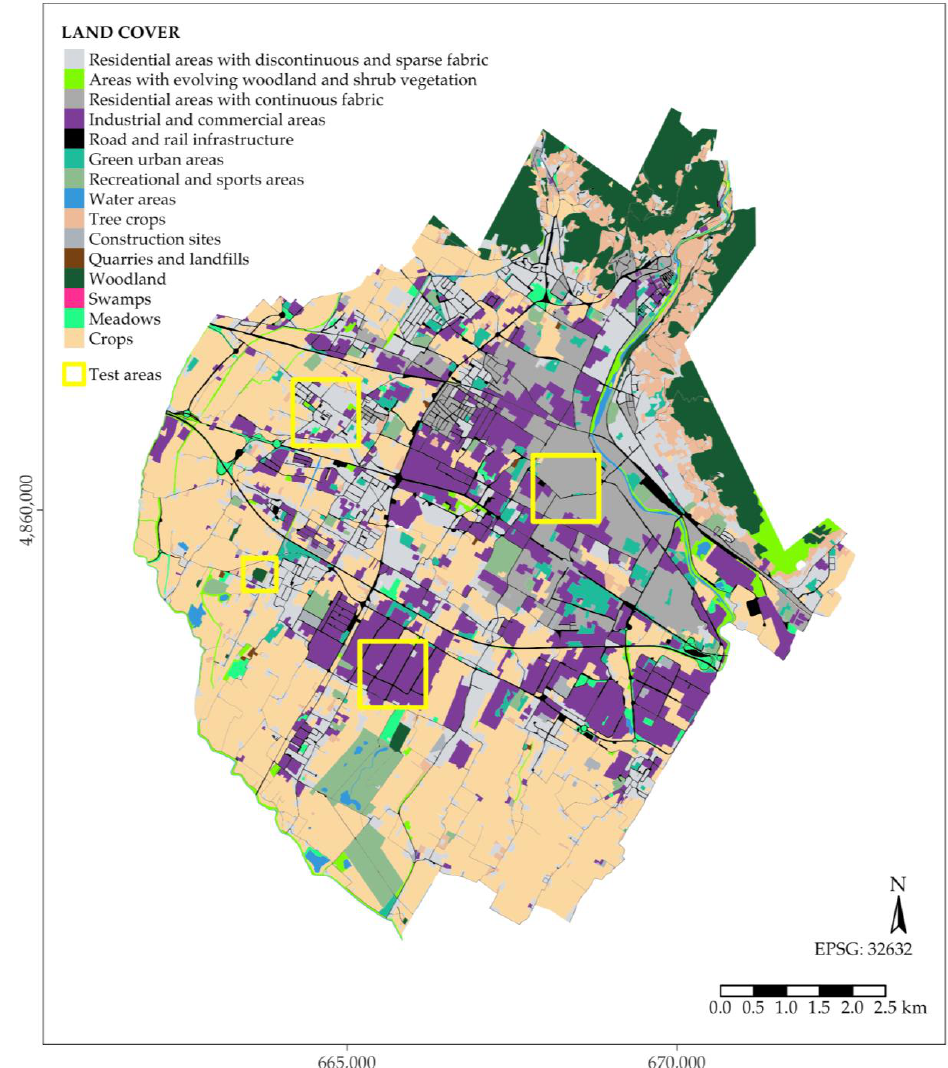
Figure 2. Simplified land cover map of the study area derived from the 2019 land cover classification available on the Toscana geoportal [45]. available on the Toscana geoportal